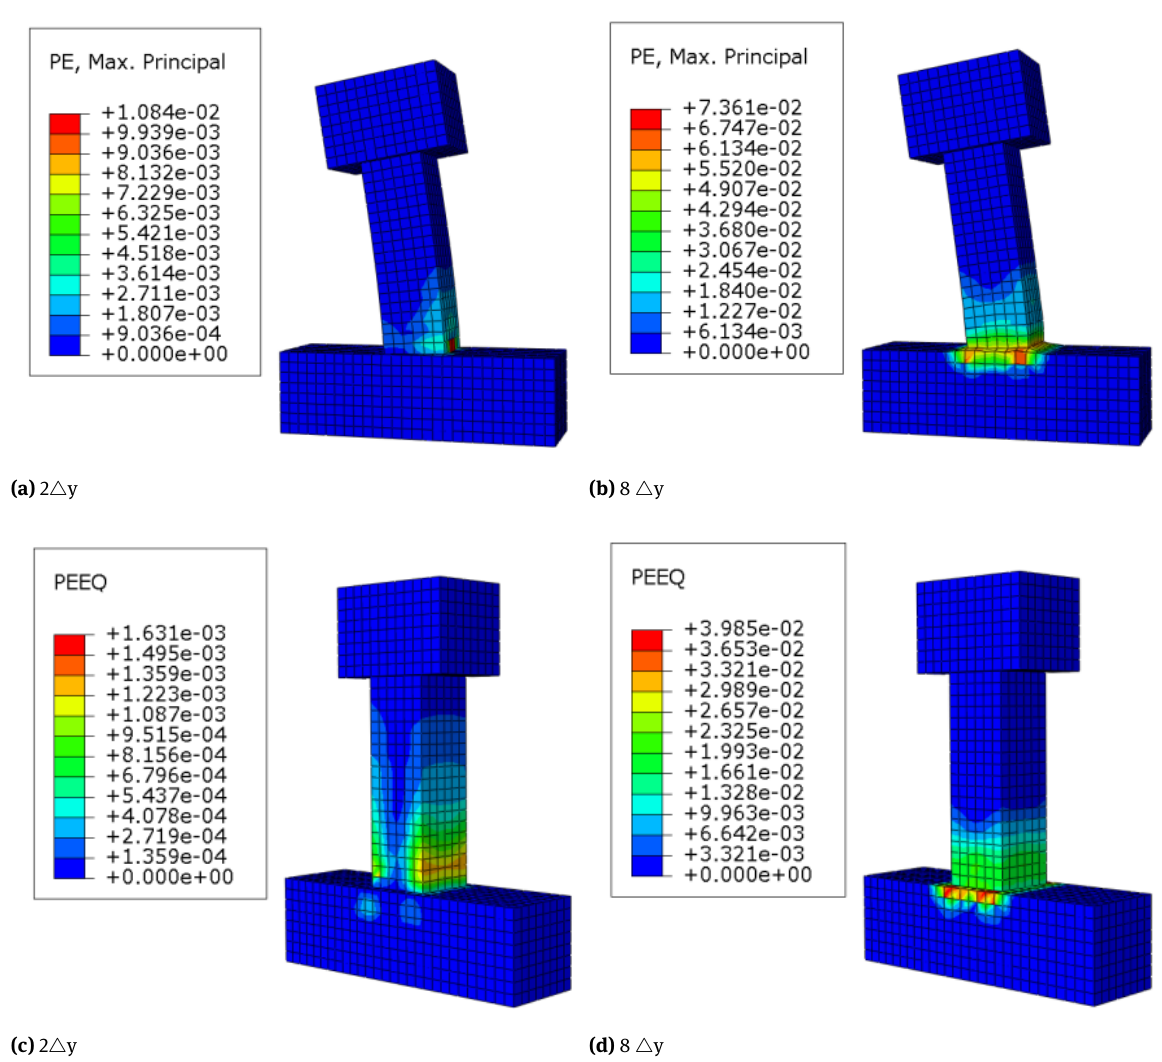
Figure 12: Nephograms of Equivalent Plastic Strain and Maximum Principal Plastic Strain of C4